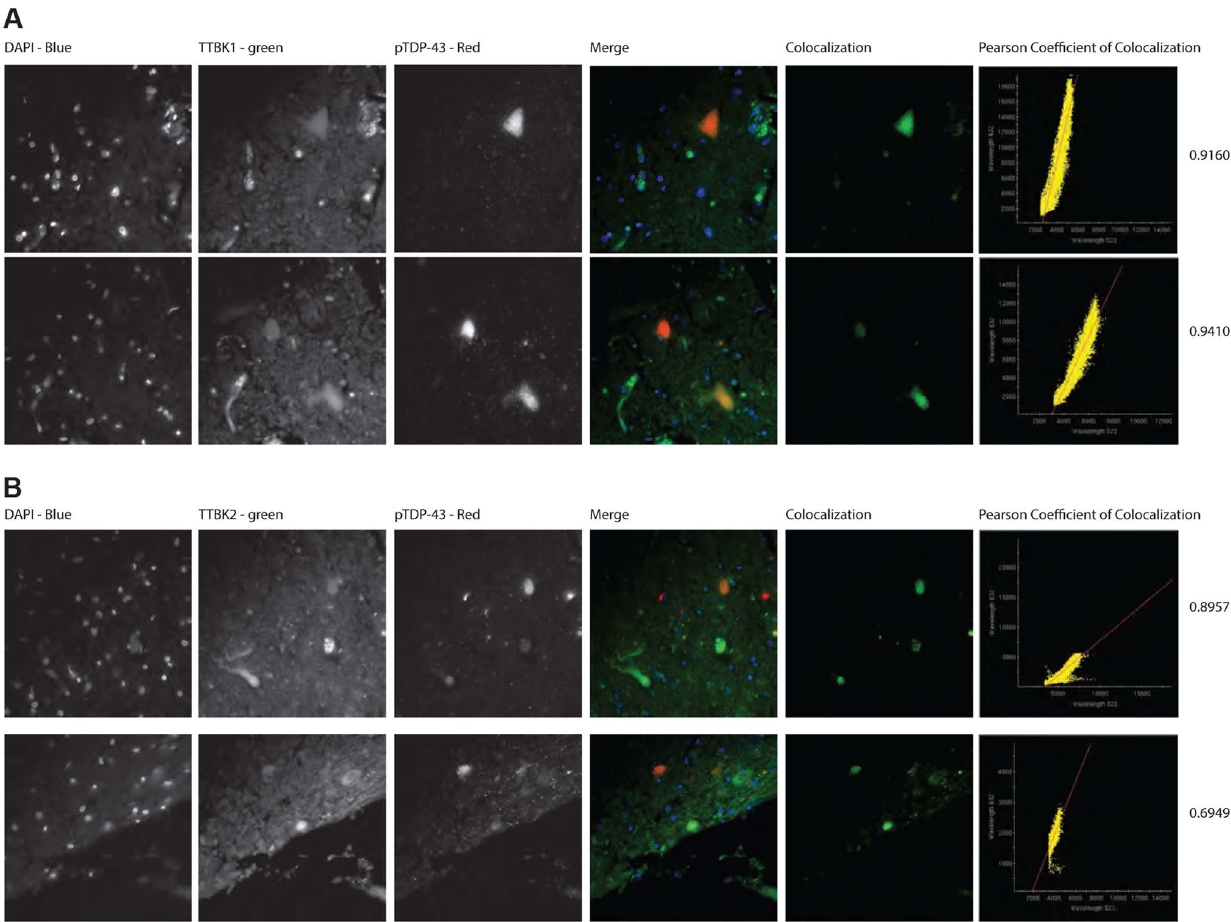
Figure 6. TTBK1/2 co-localize with phosphorylated TDP-43 in ALS spinal cord aggregates. Double-label immunofluorescence of ALS spinal cord of (A) TTBK1 and (B) TTBK2 show significant co-localization of TTBK1/2 with phospho-TDP-43 within neuronal cytoplasmic inclusions. Significance was determined using Pearson coefficient of colocalization.